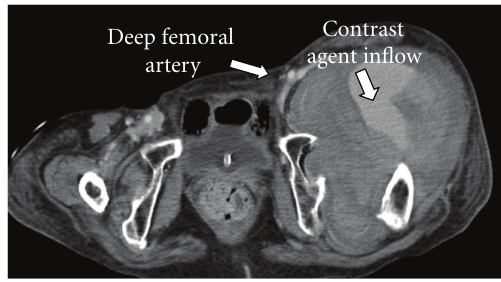
Figure 2: Contrast-enhanced CT.